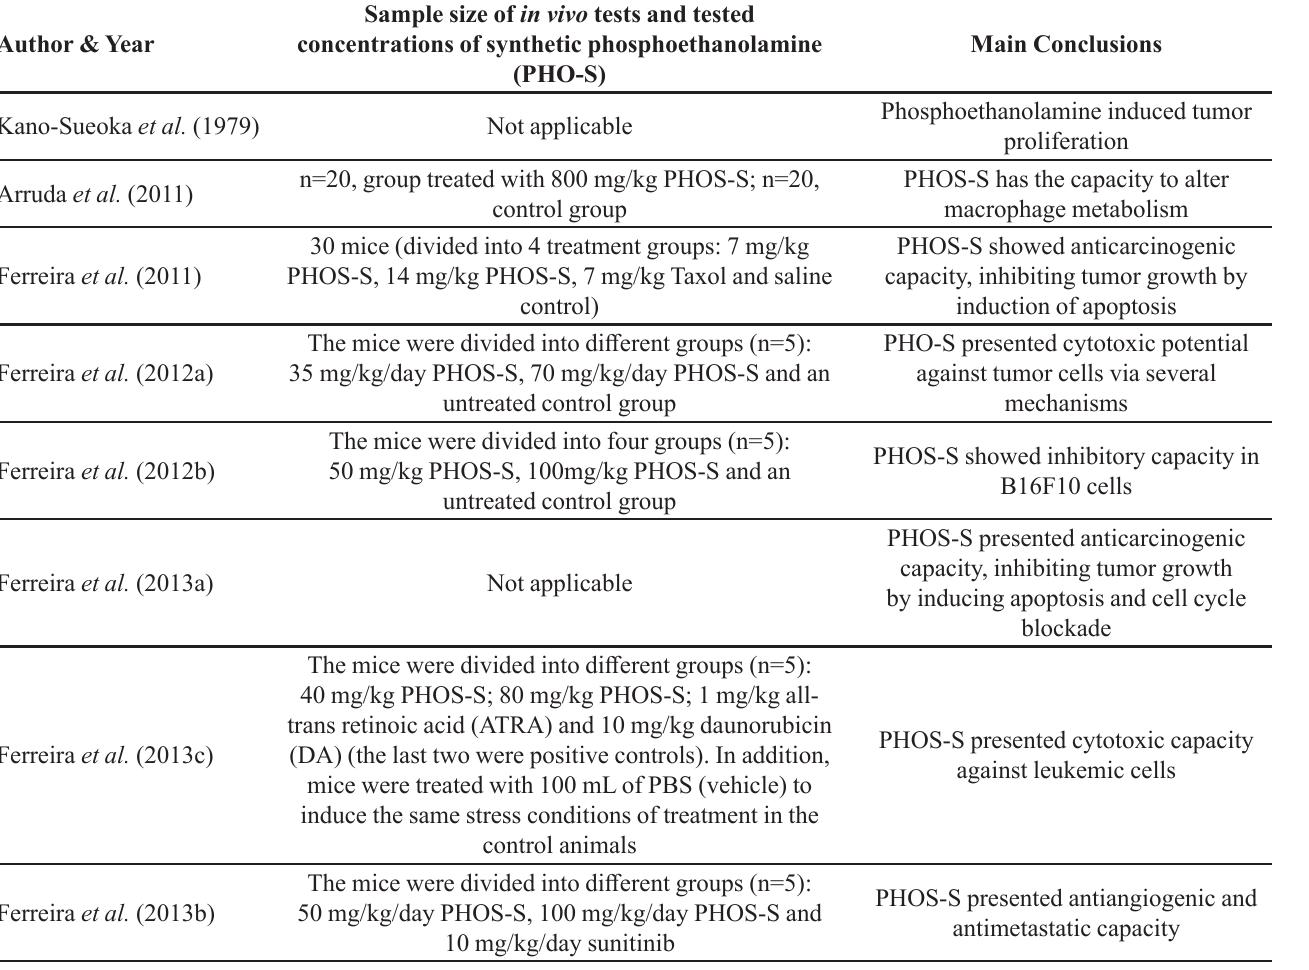
TABLE I - Description of the articles included in the systematic review of the synthetic phosphoethanolamine and its